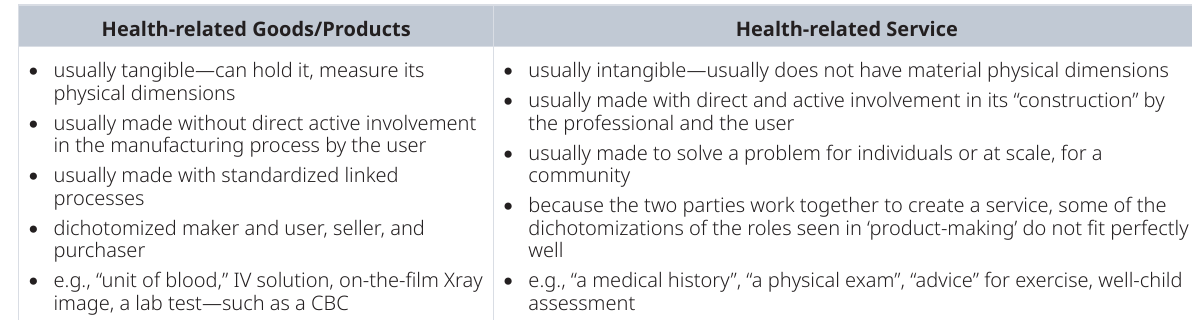
Table 2. Difference between Health Products and Health Service. Health-related